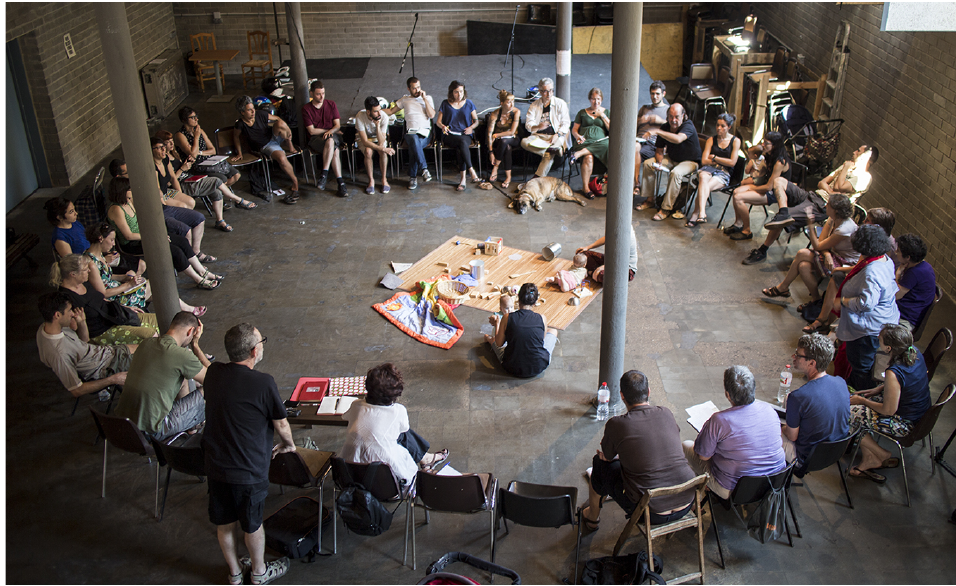
Figure 19. La Borda general assembly , Barcelona. Image courtesy of La Borda. Note: All decisions—from the design to the management of the building—are collectively taken in general